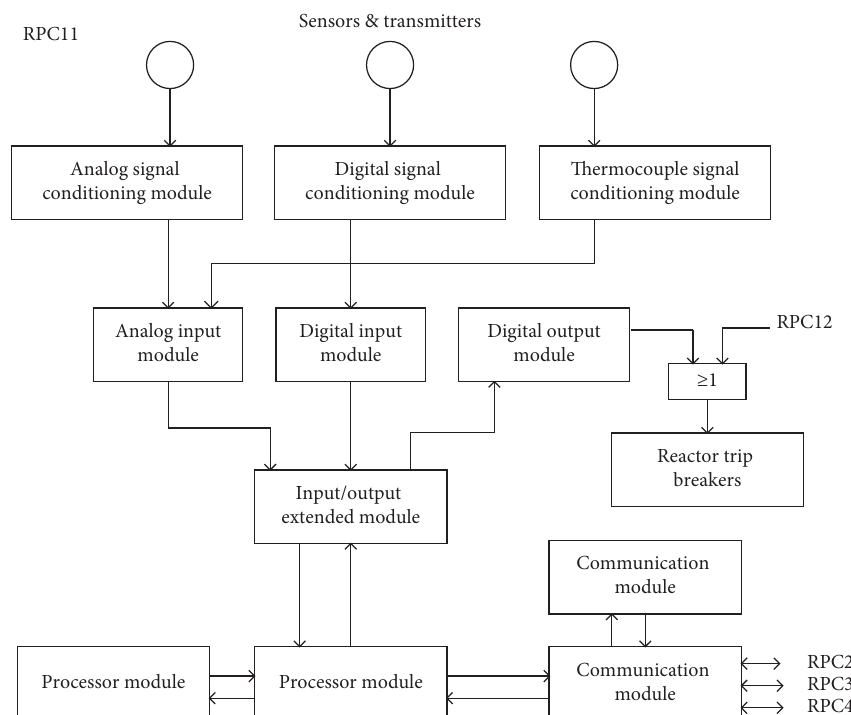
Figure 2: The layout of subchannel-1 of Channel